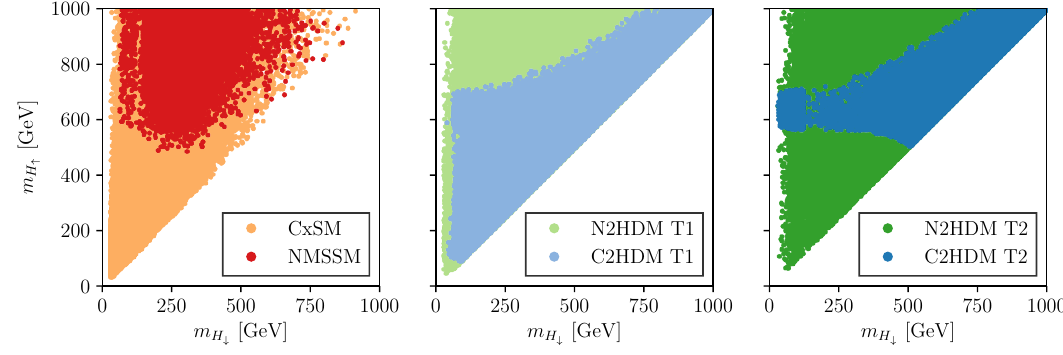
Figure 1 . Masses of the two non- h 125 neutral scalars. Left: the CxSM (orange) and NMSSM (red); middle: the type I N2HDM (fair-green) and C2HDM (fair-blue); right: the type II N2HDM (dark-green) and C2HDM (dark-blue). For the CxSM, NMSSM and N2HDM the two masses in the axes are for CP-even Higgs bosons, whereas for the C2HDM they are for CP-mixed Higgs bosons . By de(cid:12)nition m H m H # (cid:20) "